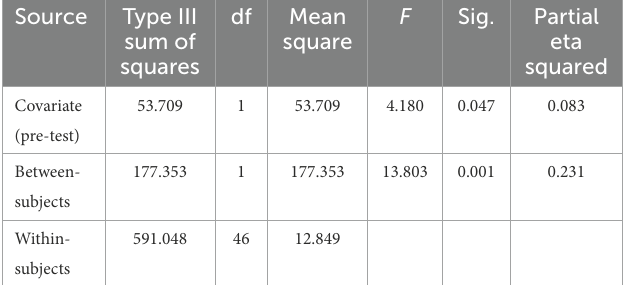
TABLE 3 ANCOVA results for writing motivation.